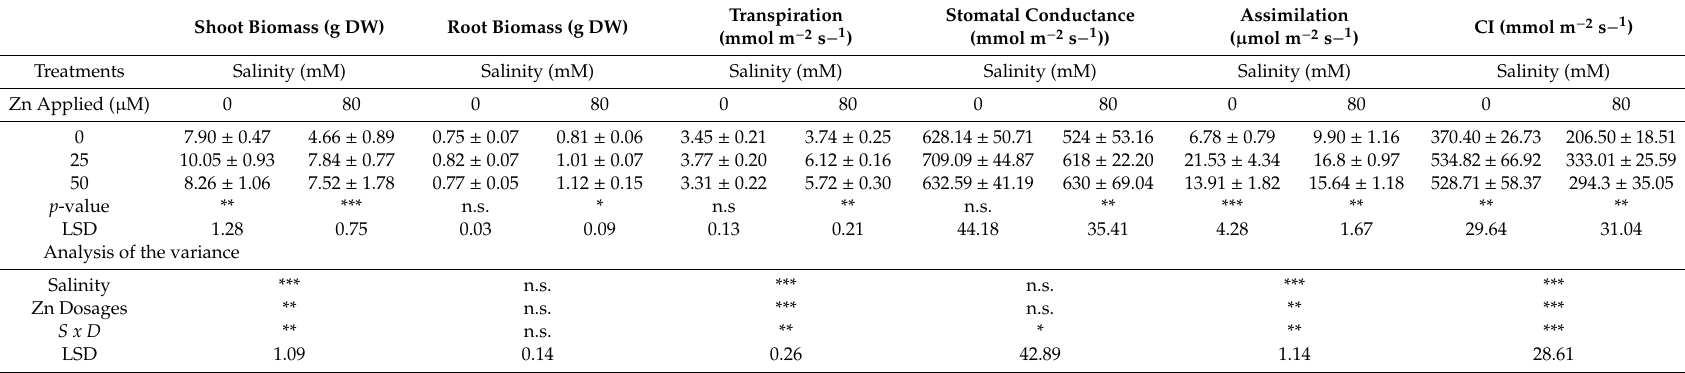
0.14 28.61 Biomass expressed as: g plant − 1 . Transpiration, stomatal conductance and CI expressed as: mmol m − 2 s − 1 . Assimilation expressed as: µ mol m − 2 s − 1 . Levels of significance are